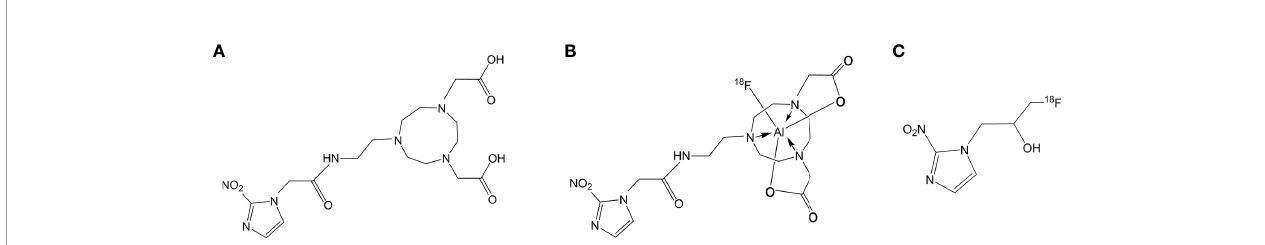
FIGURE 1 | (A) Structures of NOTA-NI. (B) Structures of Al 18 F-NOTA-NI. (C) Structures of 18